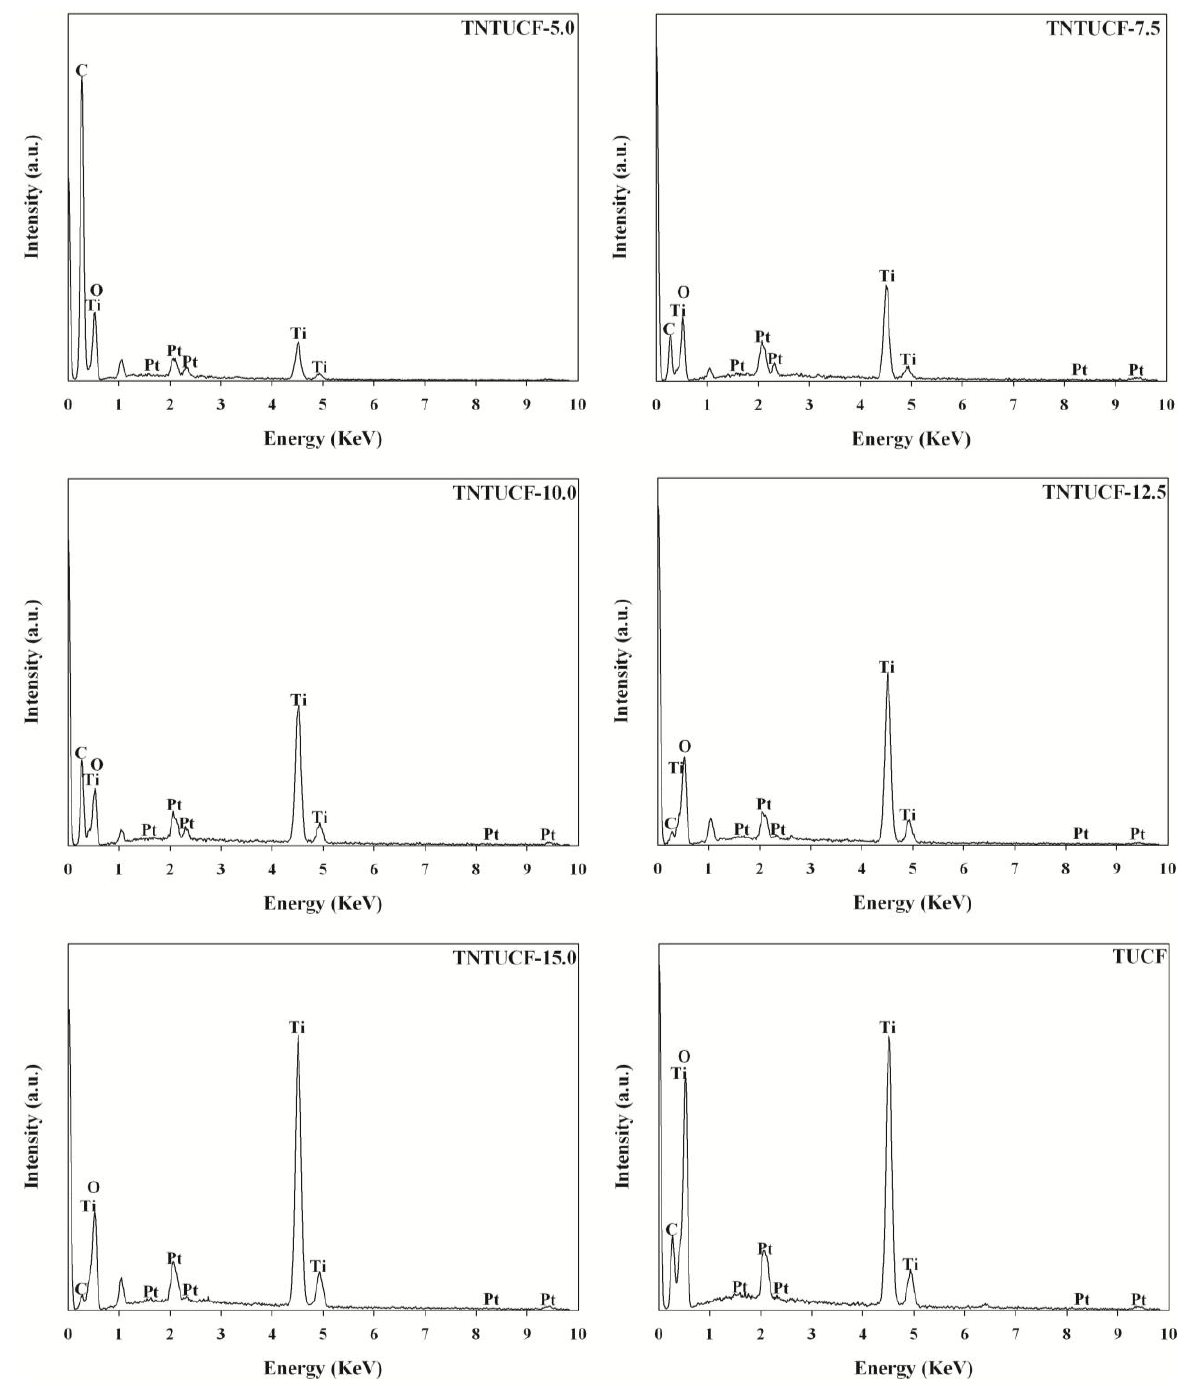
Figure 3. Energy-dispersive X-ray (EDX) of five TNTUCFs with different TiO (TNTUCF-5, TNTUCF-7.5, TNTUCF-10, TNTUCF-12.5, TNTUCF-15) and